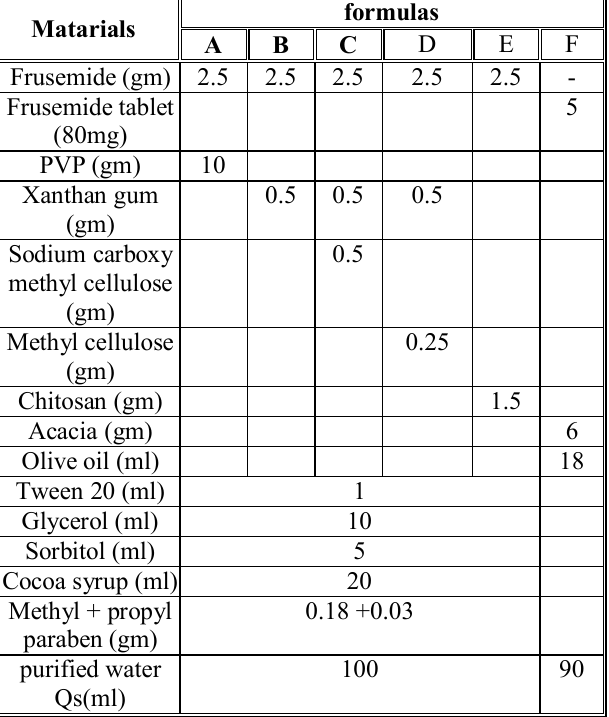
Table (2): Different formulas of